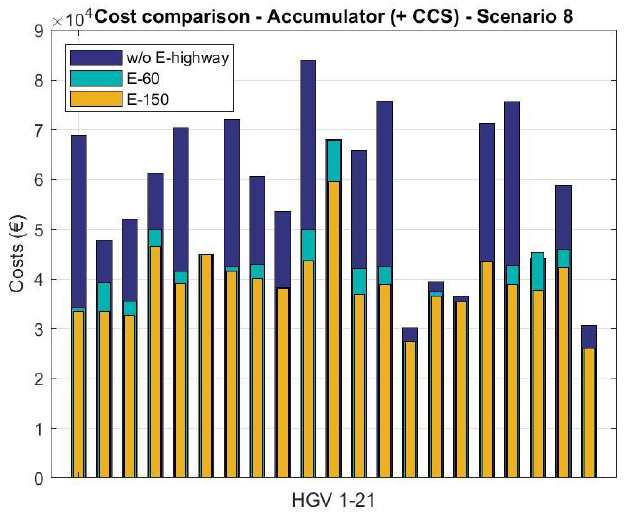
Figure 10. Costs for trucks individually—350 kW charging stations at 20% of all locations (own il- lustration).